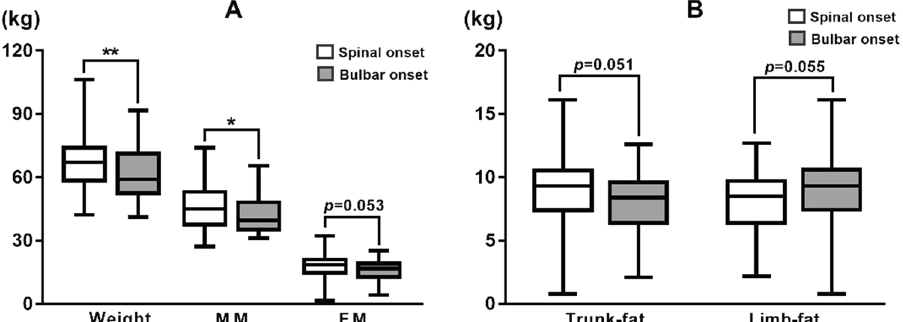
Figure 1. Weight and body composition in ALS patients grouped by site of onset. ( A ) Patients with bulbar onset had a significantly lower weight and MM than those with spinal onset. ( B ) FM in trunk was relatively lower in patients with bulbar onset while FM in limbs was relatively higher in these patients than in those with spinal onset. MM muscle mass, FM fat mass. *p < 0.05; **p <